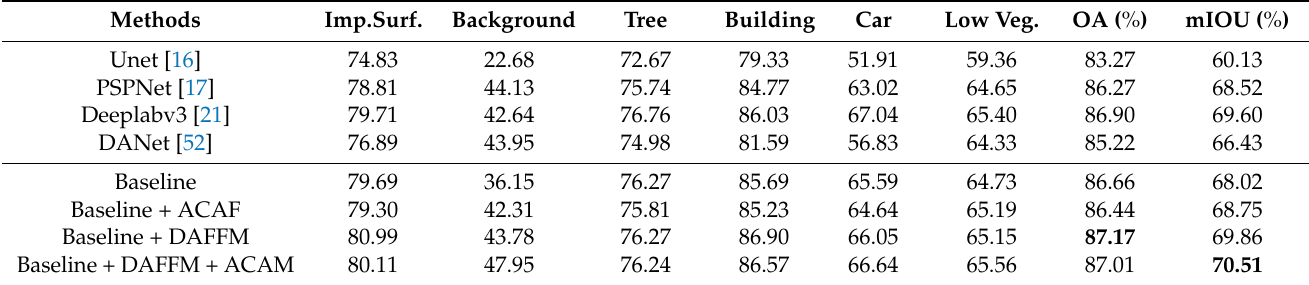
Table 3. Comparison with state-of-the-art methods on ISPRS 2D Semantic Labeling Vaihingen data [35]. Methods